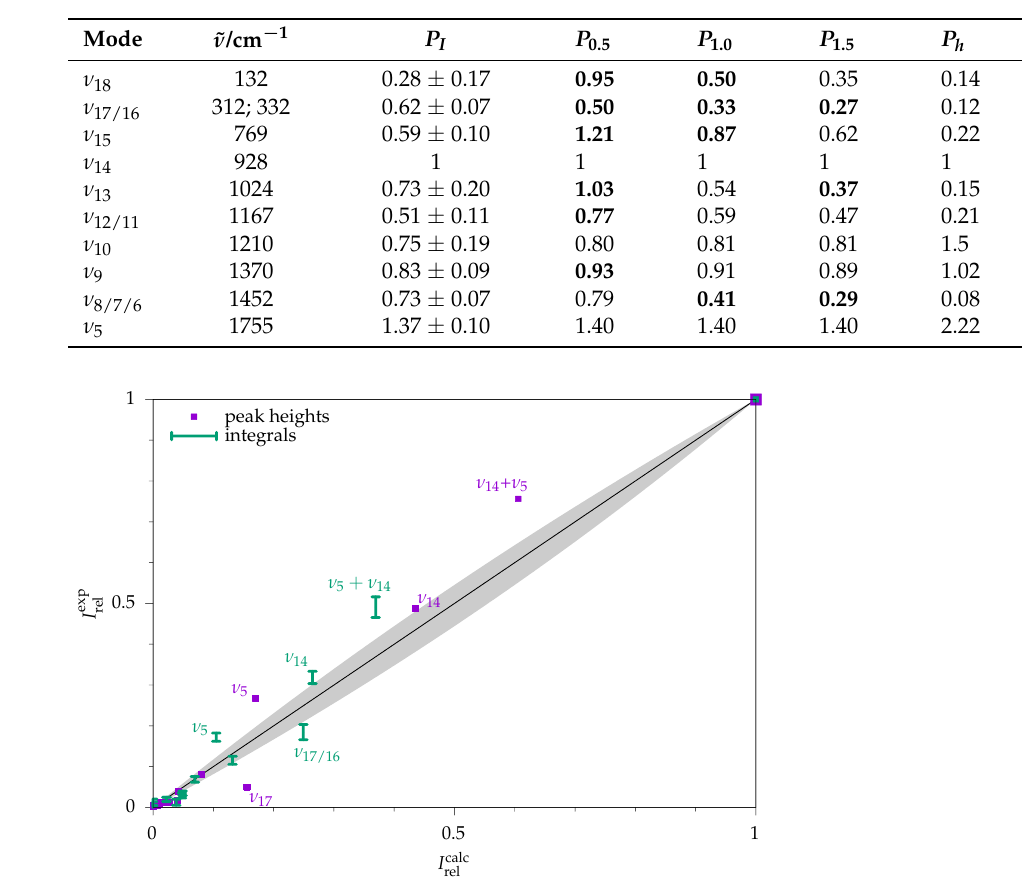
Table 3. Individual scaling factors P needed to match harmonic theoretical predictions (B3LYP/def2- QZVPP) to the relative experimental Raman intensity (Table 1, Figure 7), normalised to ν 14 . P I matches integrated intensities, P σ matches peak heights for a given Gaussian simulation width σ /cm − 1 . P σ that are outside the error margin of P I are marked bold. P h matches calculated Raman cross sections to experimental peak heights, for reference. For ν 17/16 , the average of P σ ( ν 17 ) and P σ ( ν 16 ) is given.